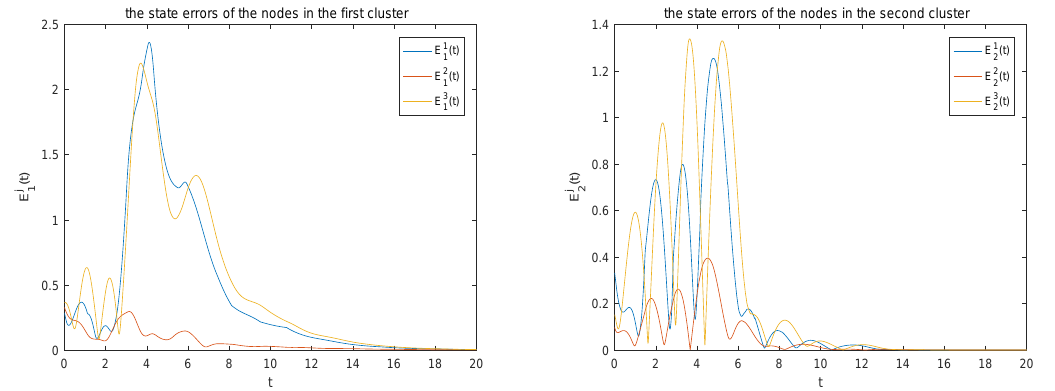
Figure 3. The behavior of state error E j